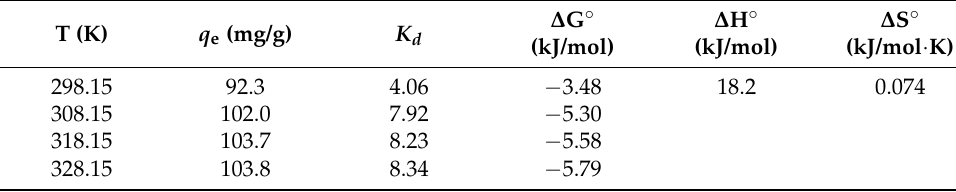
Table 9. Thermodynamic parameters for MB dye adsorption onto